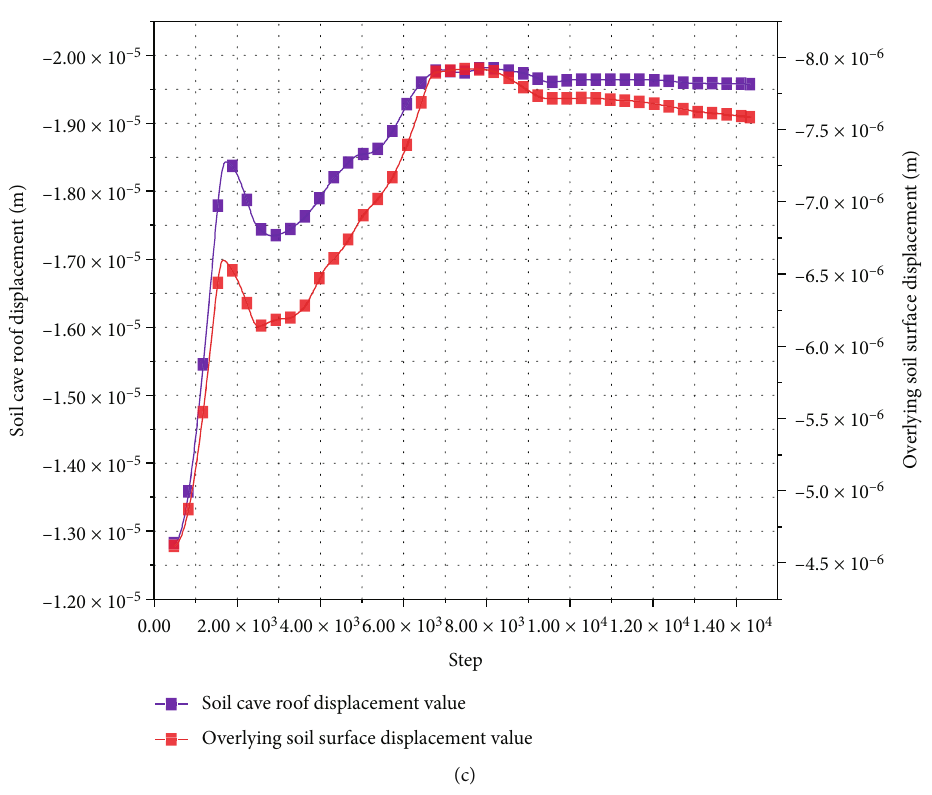
Figure 12: Deformation of overlying soil during water level droping. (a) Variation of cave roof displacement with time steps during the dropping of di ff erent initial water levels. (b) Variation of cave roof displacement under di ff erent initial water levels dropping. (c) When the initial water level height is 100mm, the displacement of the roof of cave and the displacement of the overlying soil variation with time